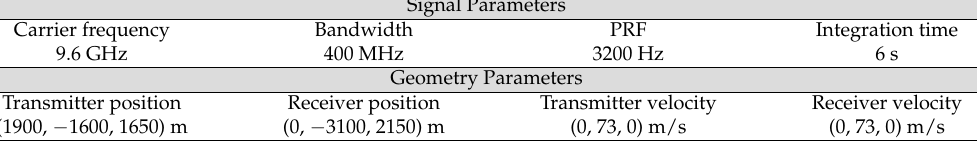
Table 3. Experiment